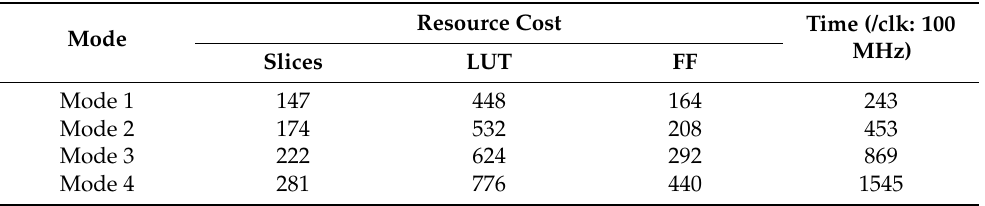
Table 6. The time and resource cost for four detection